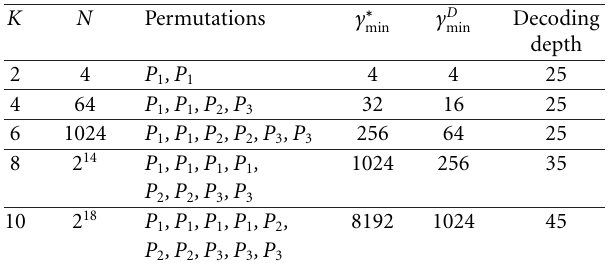
Table 3: ST codes for QPSK